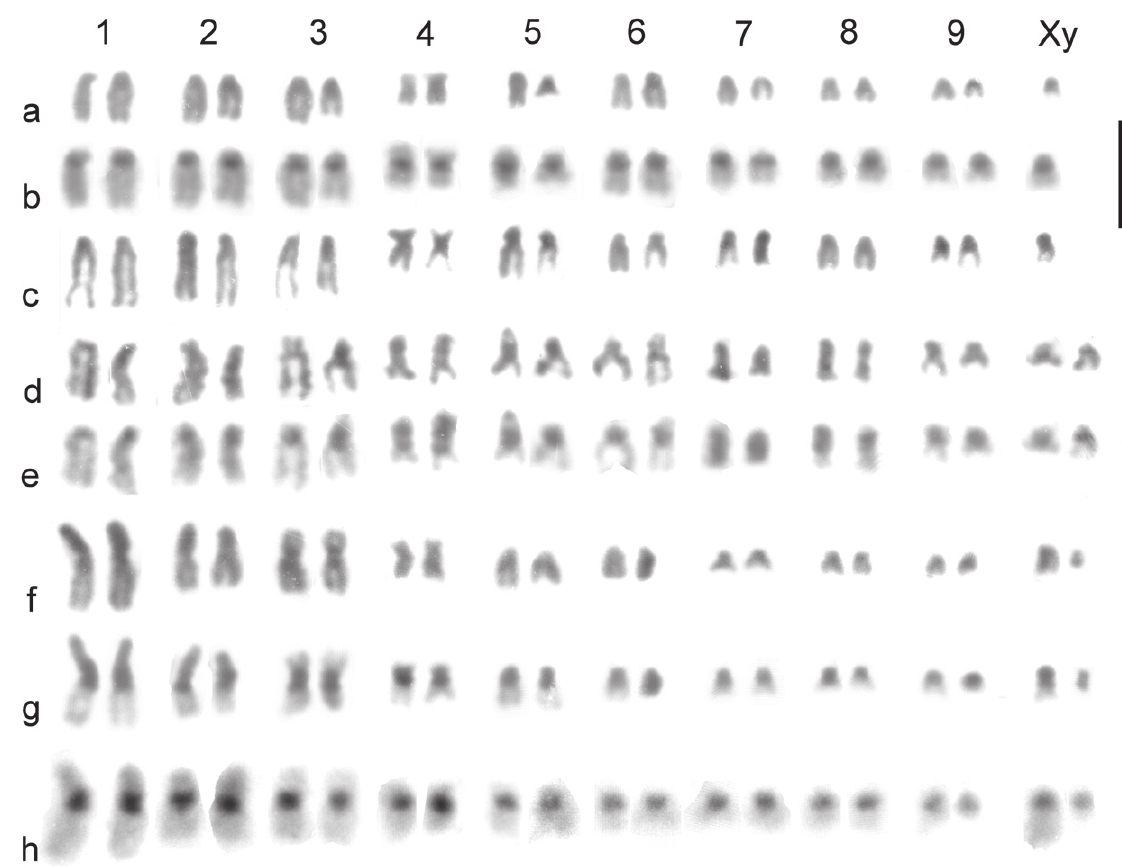
Fig. 2, a-h. Mitotic chromosomes from mid-gut cells of Aphodius abdominalis ( a-e ) and A. bonvouloiri (f-h), arranged as karyotypes. a - ♂, plain. b - the same nucleus, C-banded (nuclei shown in Fig. 1, a, b). c - ♂, plain. d - ♀, plain. e - the same nucleus, C-banded (nuclei shown in Fig. 1, c, d). f - A. bonvouloiri , ♂, plain (nucleus shown in Fig. 1, g). g - A. bonvouloiri , ♂, lightly C-banded (nucleus shown in Fig. 1, h). h - A. bonvouloiri , ♂, heavily C-banded. Bar =